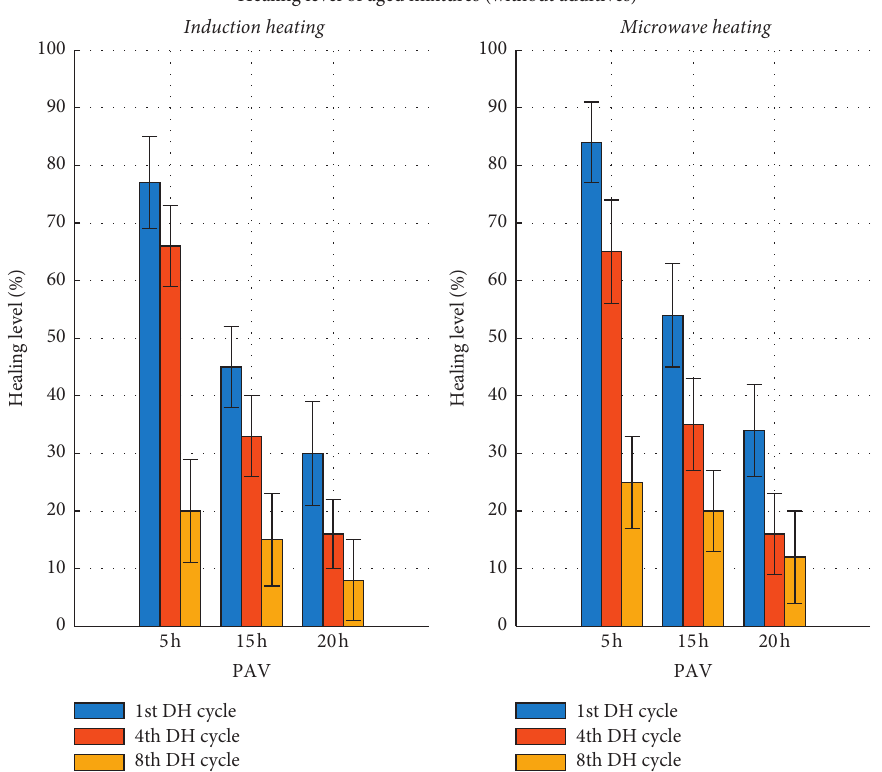
Figure 12: Healing level of aged mixtures without additive